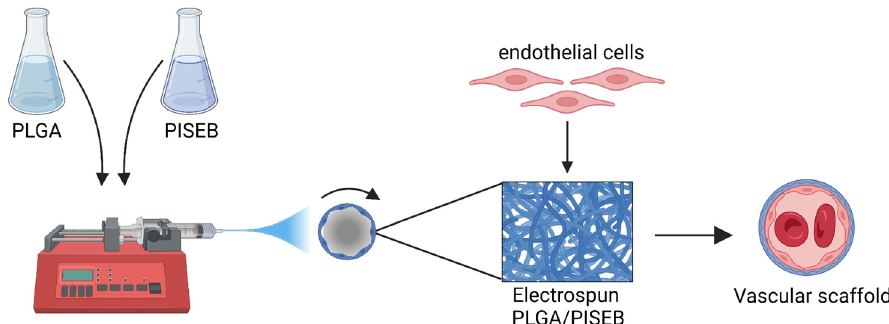
Figure 1. Graphical representation of the concept of using electrospun PLGA/PISEB materials facilitating the outgrowth of endothelial cells as vascular scaffolds. Created with BioRender.com.